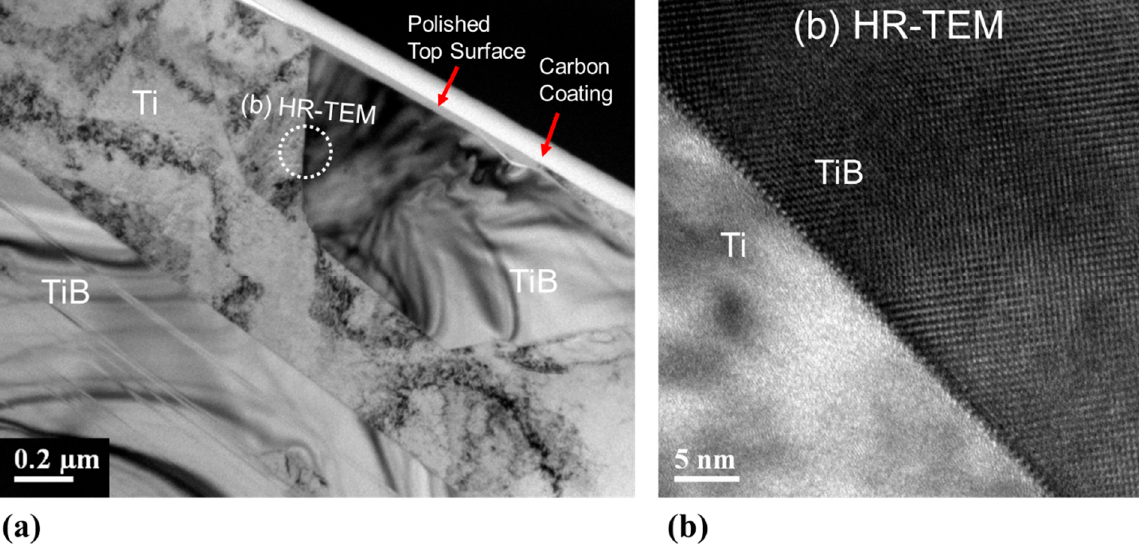
Figure 6. ( a ) High ‐ angle annular dark ‐ field STEM image highlighting the interface of the Ti matrix and a TiB particle. ( b ) Corresponding EELS mapping overlay from the region indicated by the Spec ‐ trum Image box, with Ti shown in green and B in yellow. ( c ) Line scan across the Ti–TiB interface highlighting a sharp interface with no voids or discontinuities in the material at the boundary, taken from the line indicated in ( a ).